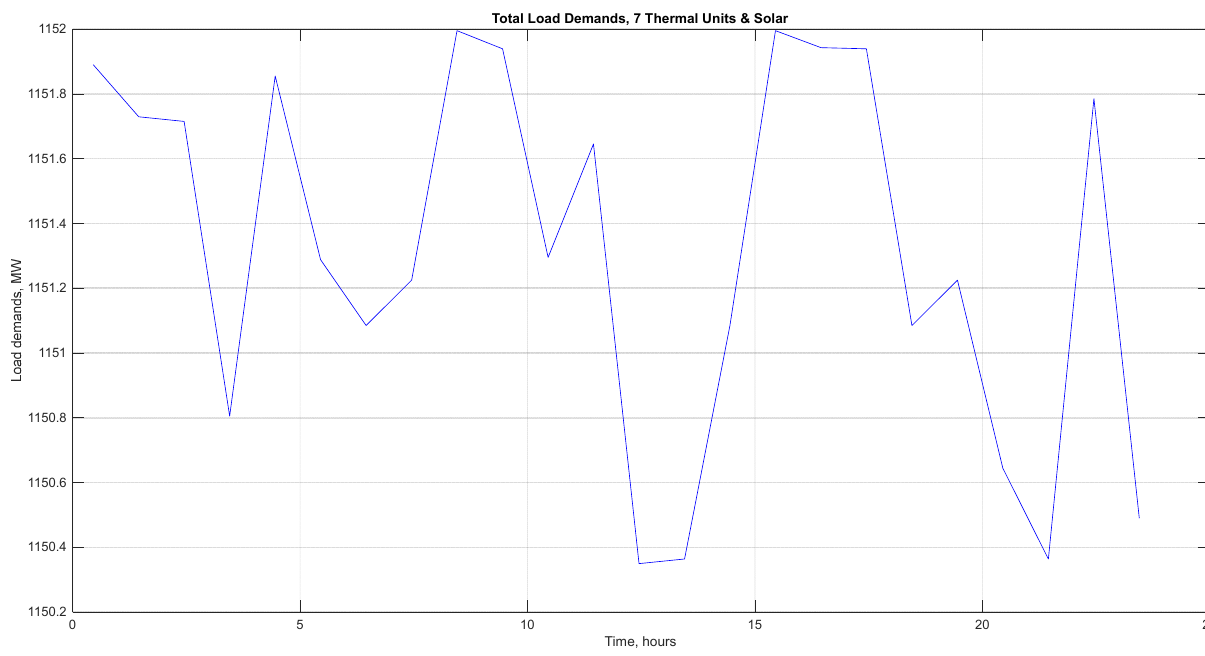
Figure 1. Solar Clear-sky irradiance, on a 2-axis tracking plane, in the month of July, at Ptolemaida, NW Greece, latitude/longitude: 40.463/21.762, during 24 h.